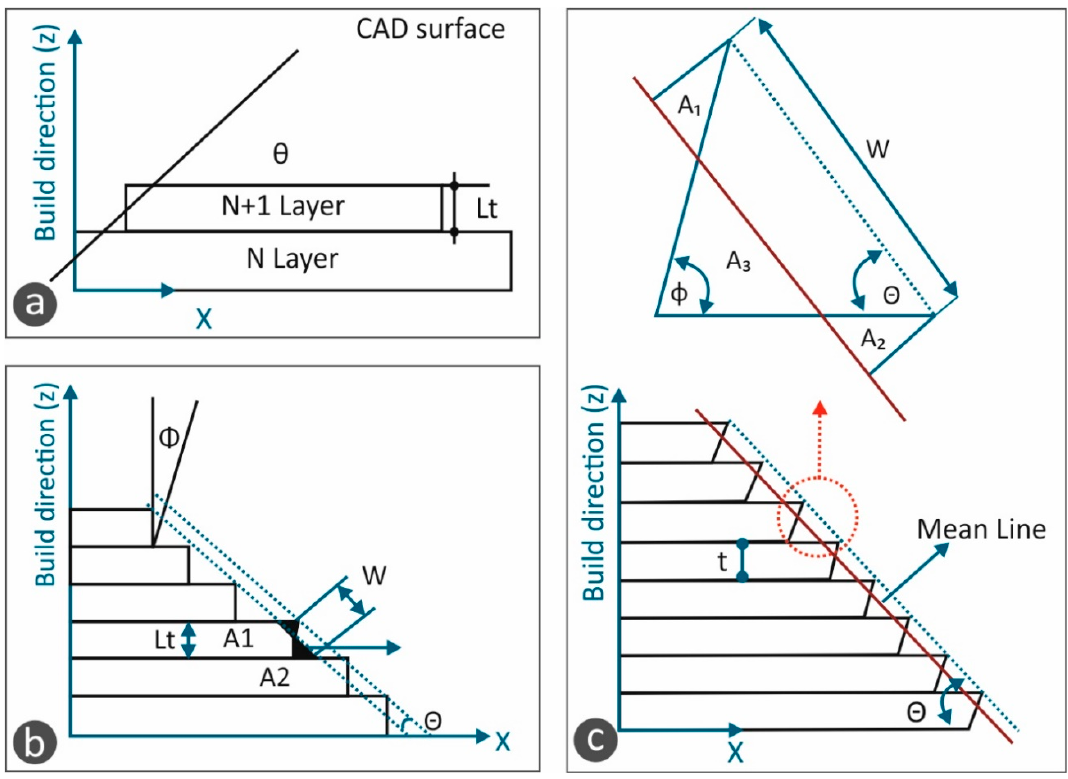
Figure 1. ( a ) Platform setup—side view [4]; ( b ) modified model proposed by Ahn, Kim and Lee [16]; ( c ) model proposed by Kumar and Kumar [17].